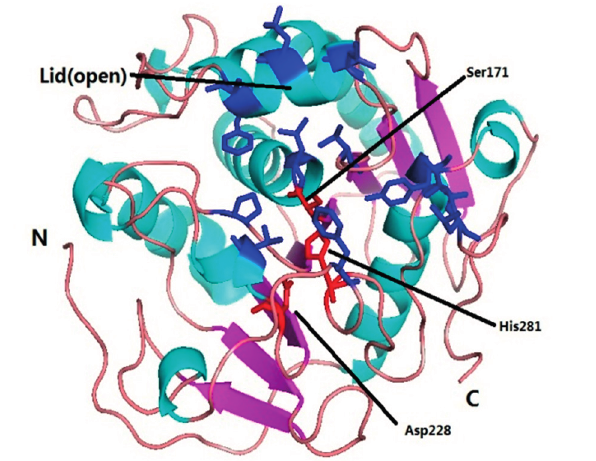
Figure 6. Cartoon view of the modeled Mg MDL2 in the open conformation. The catalytic pocket and the residues constituted the oxyanion hole highlighted in blue, while the catalytic triads were colored